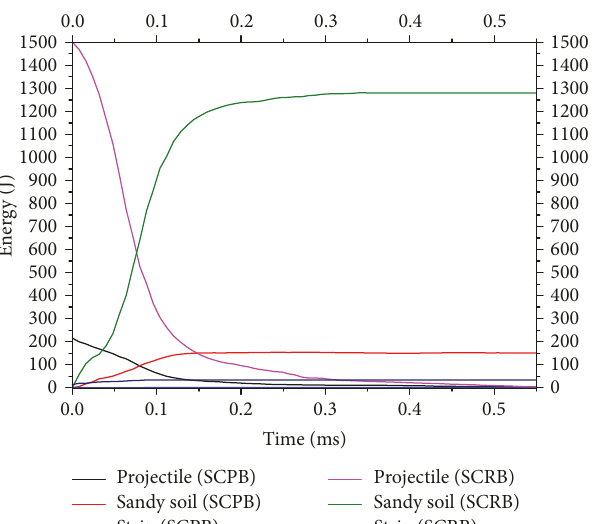
Figure23:PenetrationbyMCRBwhenaxisofprojectilewasnormal to the strip.